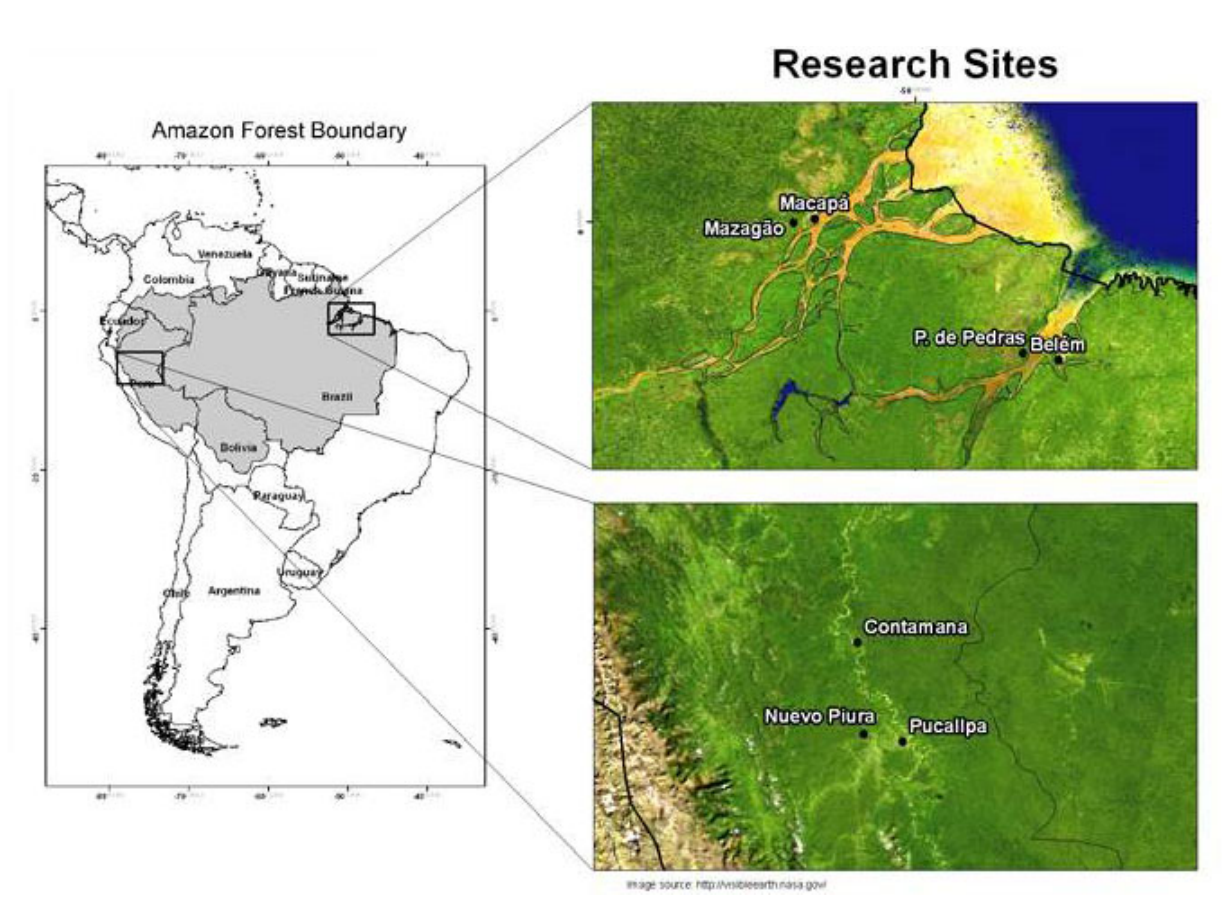
Fig. 1. Map of research